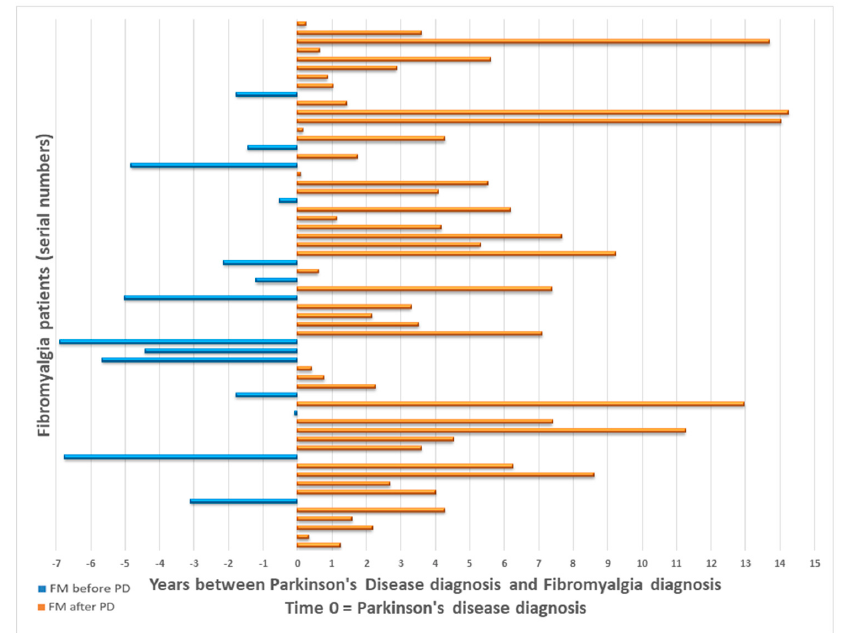
Figure 1. Parkinson’s Disease and Fibromyalgia diagnoses times. Abbreviations: FM—fibromyalgia; PD—Parkinson’s disease.